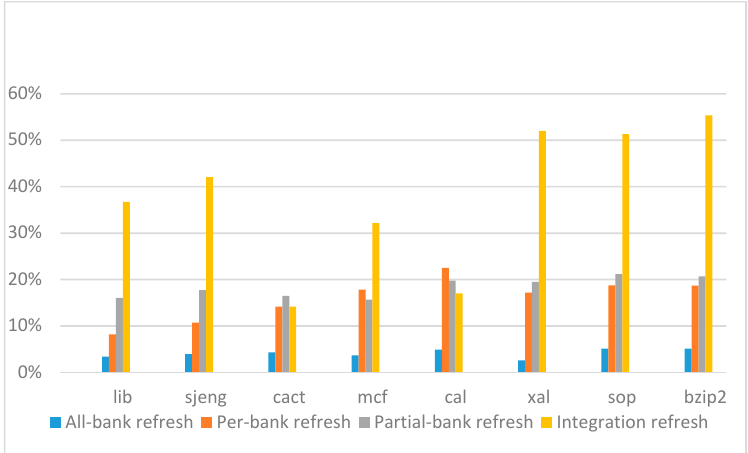
Figure 24. Energy reduction normalized to 1x granularity baseline (tRFC = 530 ns, weak row = 3%).